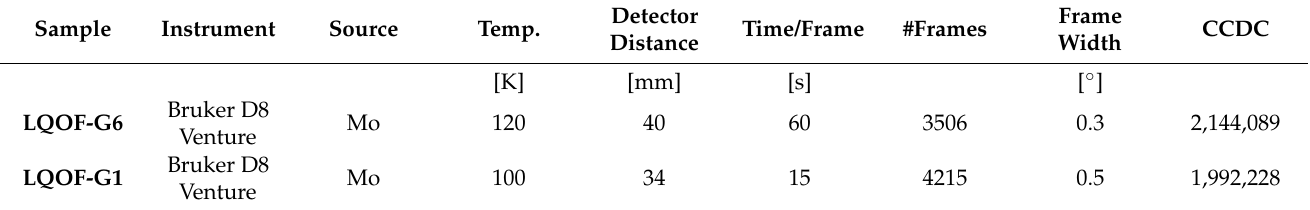
Table 2. Experimental parameters and CCDC-Code for compounds LQOF-G6 and LQOF-G1 . Sample